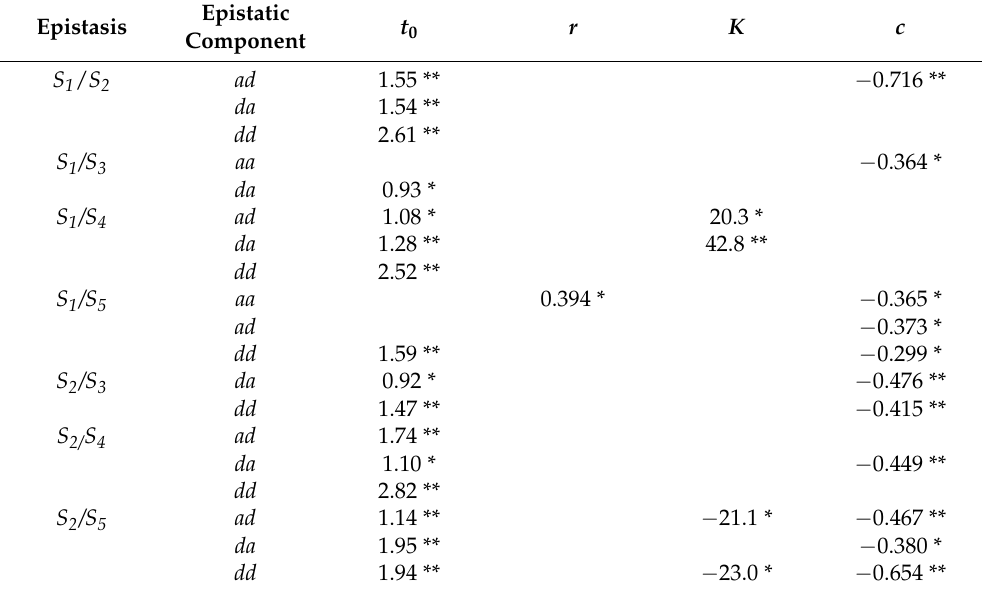
Table 7. Epistatic effects of the QTLs on the four functional parameters of the leaf numbers. SSSL is an abbreviation of single-segment substitution line. S i represents the homozygote or heterozygote i th SSSL. aa , ad , da , and dd represent the additive-additive, additive-dominance, dominance-additive, and dominance-dominance epistatic components, respectively, which were estimated by the means of ( D ij + HJX 74 − S i − S j ) (where D ij , S i , S j indicate the dual segment and its two single-segment materials, respectively, which may be homozygotes or heterozygotes). t 0 , r , K , and c are the optimum time, the growth rate, the maximum value, and the degradation rate, respectively. The sign “–” indicates descending parameters due to alleles from the donors. * and ** indicate significance at the 5% and 1% levels,